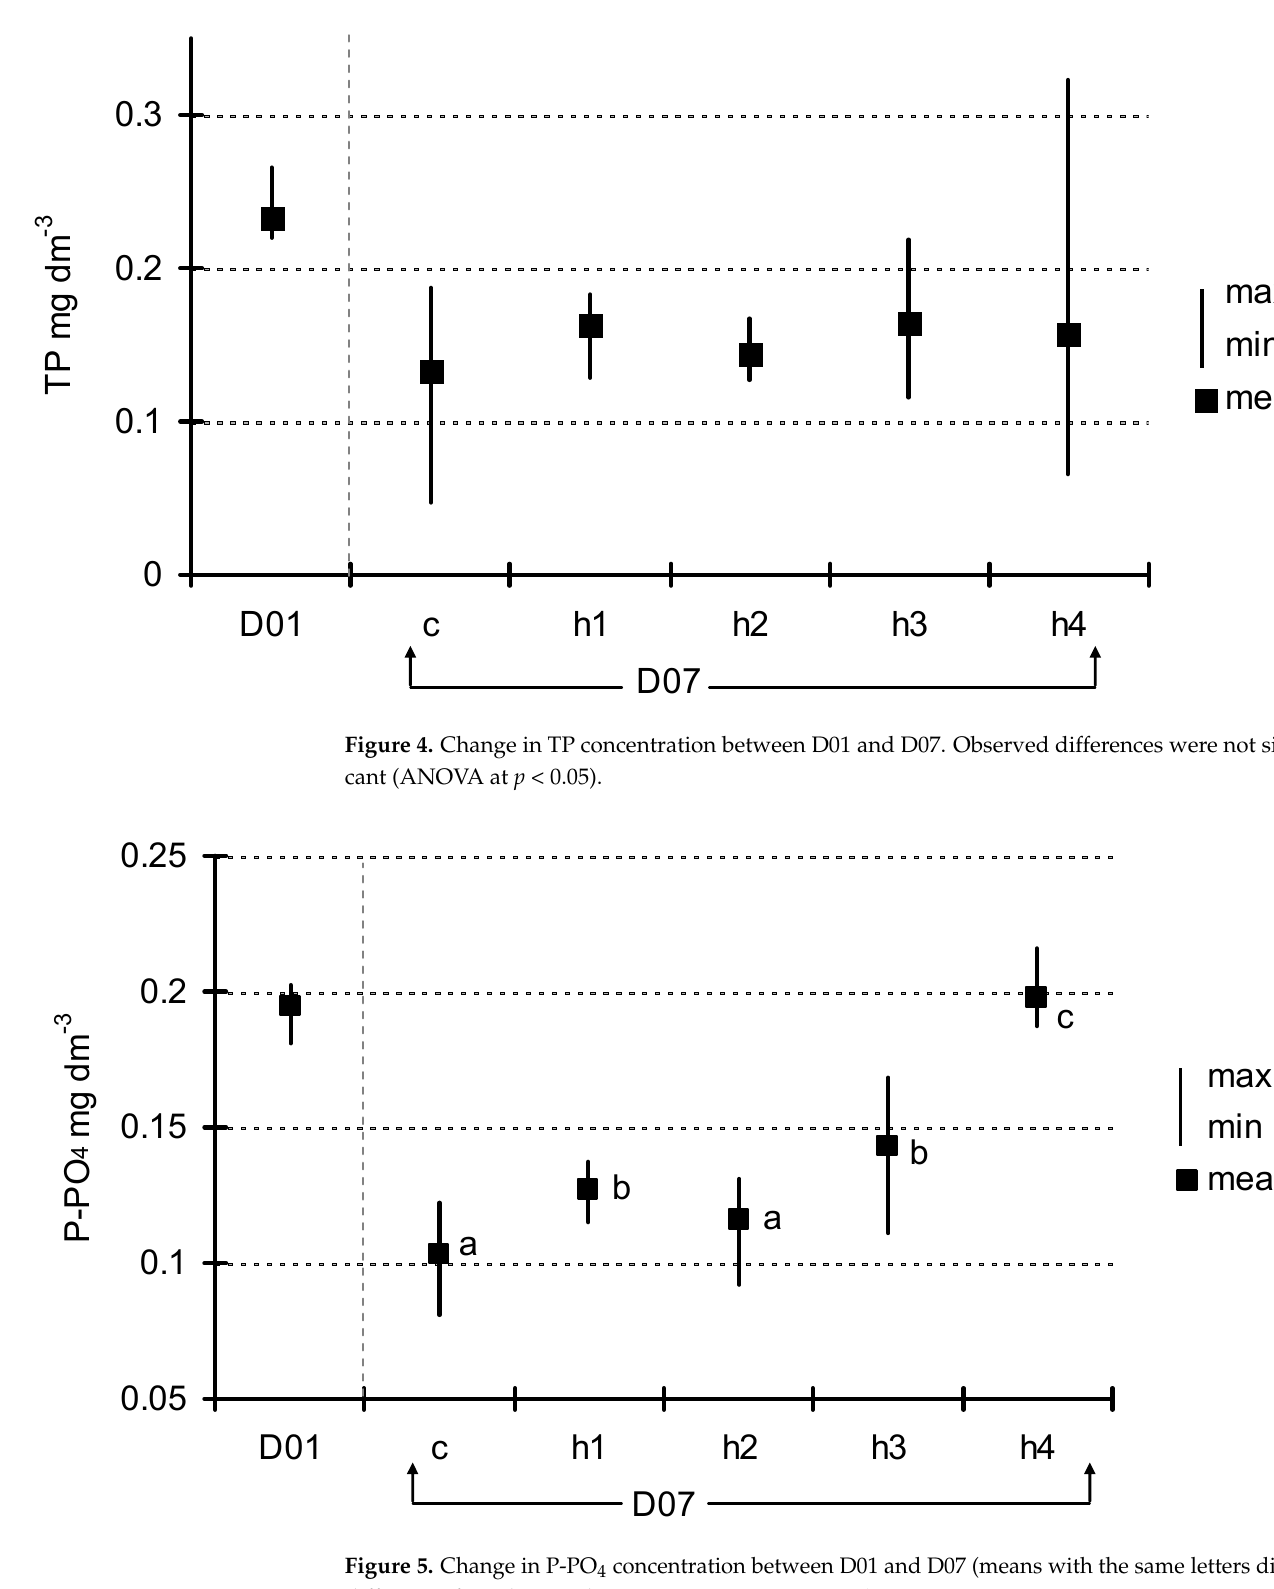
Figure 6. Change in N-NO 3 concentration between D01 and D07 (means with the same letters did not differ significantly; post hoc Duncan’s test at p < 0.05).